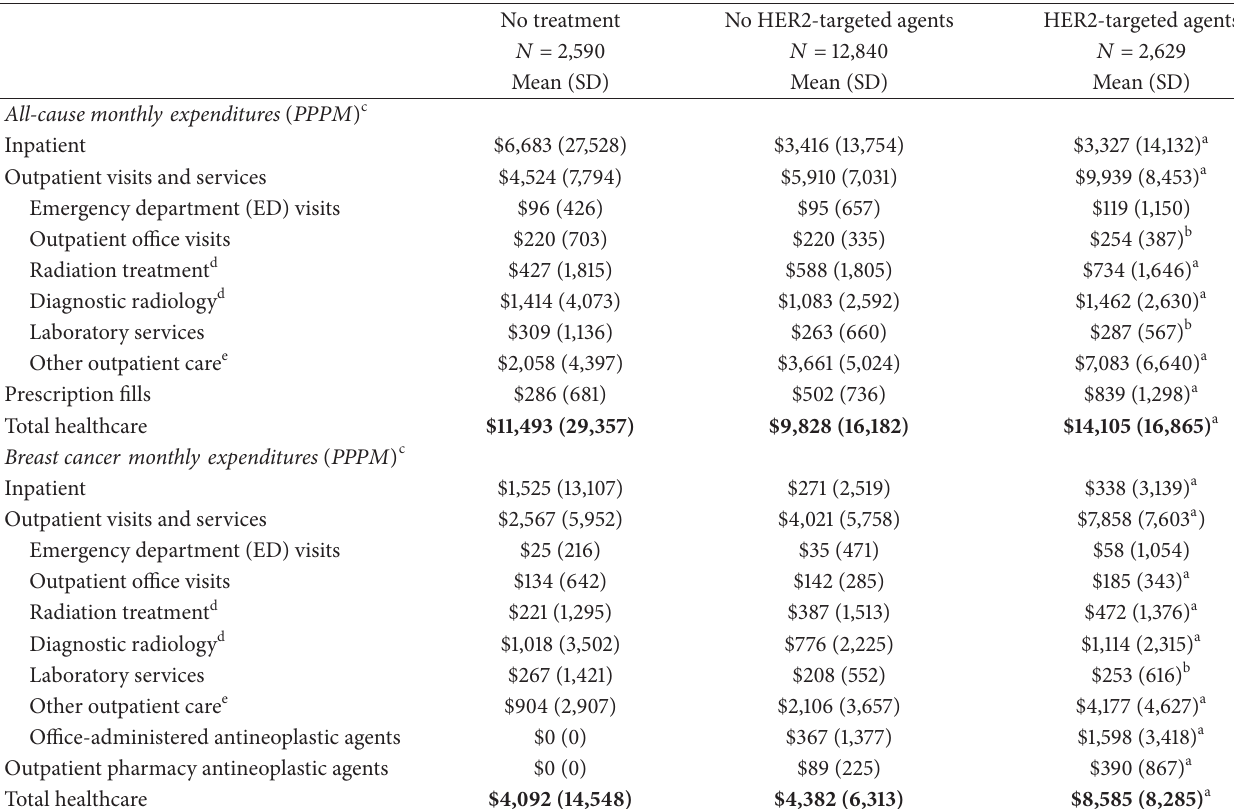
Table 5: Unadjusted healthcare costs during